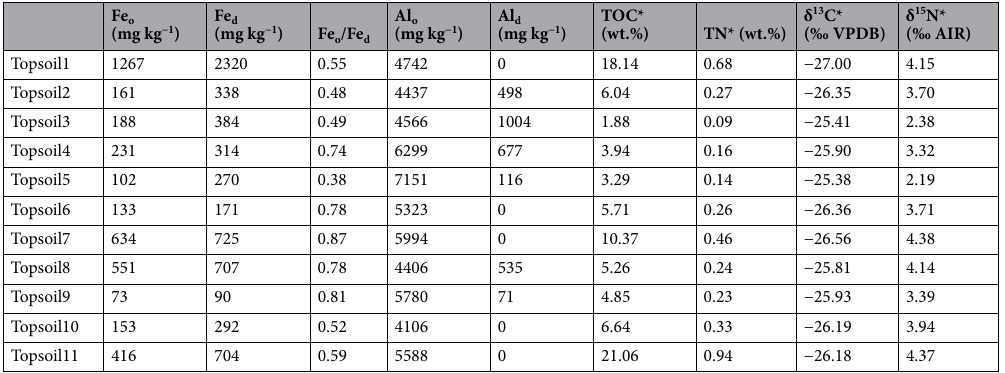
Table 2. Pedogenic oxide concentrations of Fe and Al in eleven topsoil samples (0–5 cm depth). Organic geochemical and isotope data are obtained from Klaes et al. 20 (marked with *). Subscripts refer to the treatments used for wet-chemical extraction (citrate bicarbonate dithionite—Fe d , Al d ; ammonium oxalate— Fe o , Al o